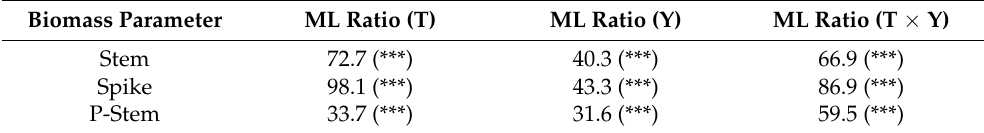
Table 3. Analysis of variance performed on stem and spike biomasses (Stem and Spike, respectively) and P content in stems (P-Stem) at the harvest stage. The variability in the biomass parameters was evaluated using the hierarchical multilevel model (maximum-likelihood (ML) ratio). T: liming treatment; Y: year. The results were significant at * p < 0.05, ** p < 0.01 and *** p < 0.001. Biomass Parameter